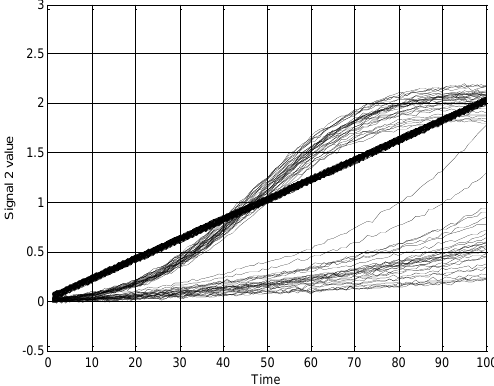
Fig. 2. Projection on the signal 2 axis of the 150 simulated transients.